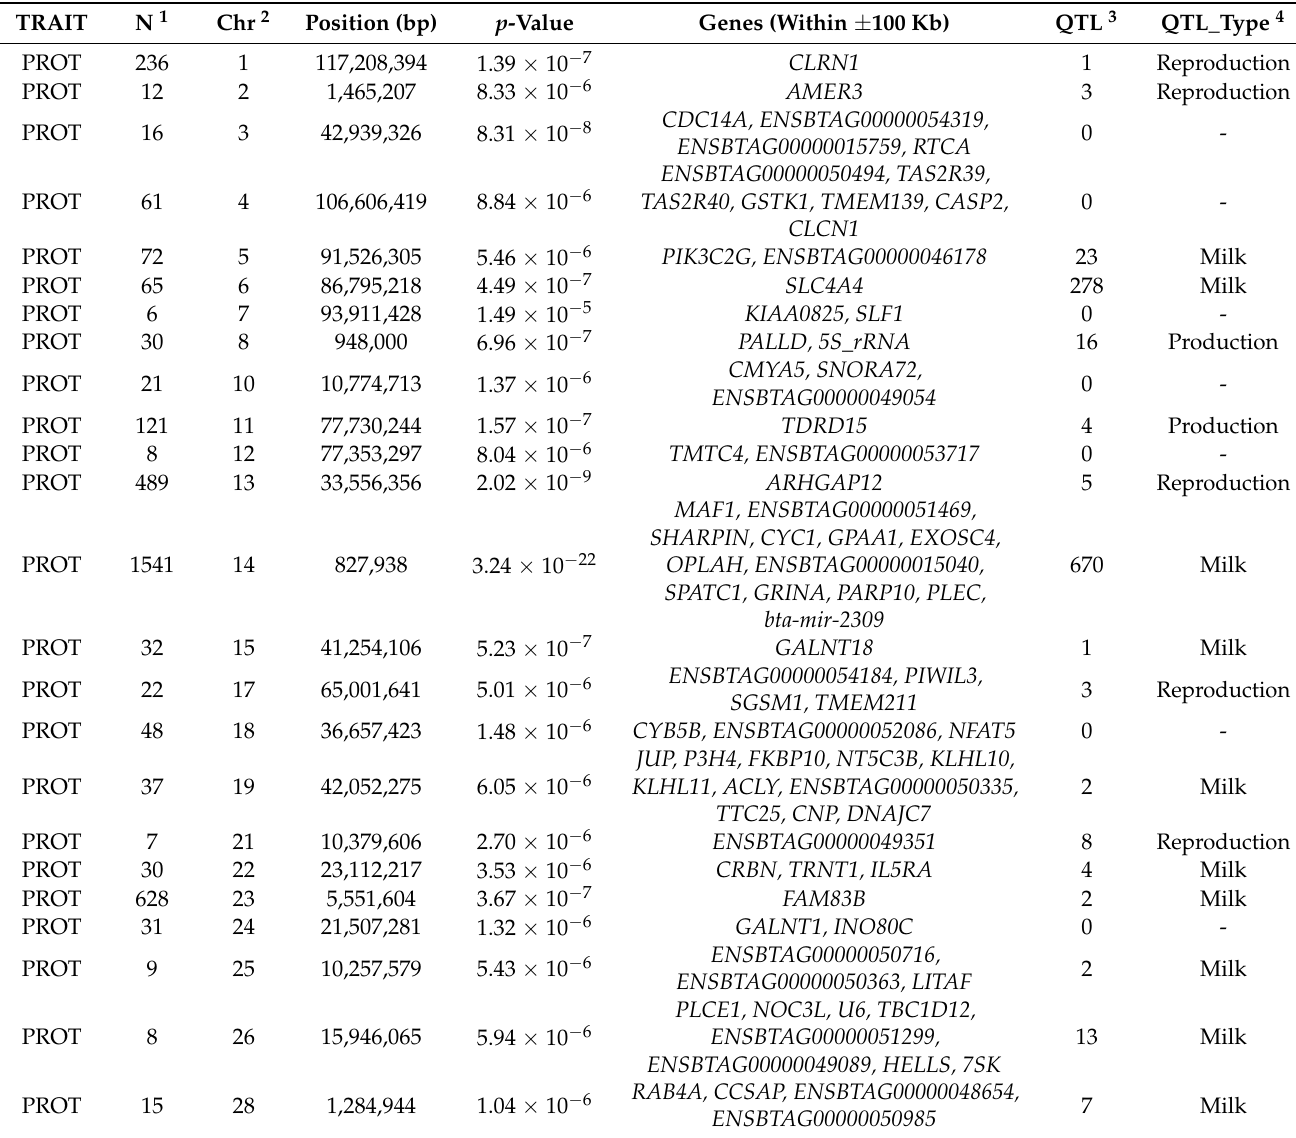
Table 3. Description of SNPs, most significant genes, and number of QTLs significantly associated with protein yield (PROT), protein percentage (PROT%), and lactation persistency (LP) in North American Holstein cattle.